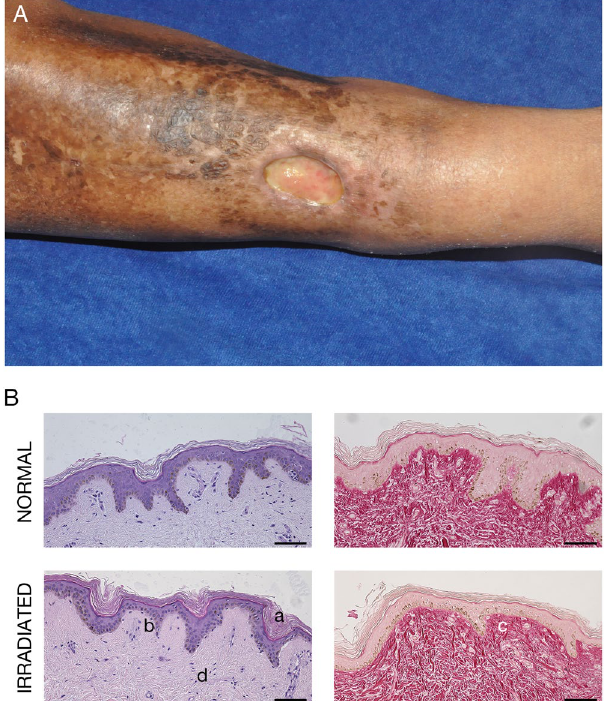
Figure 1. ( A ) Photo of a patient with a non-healing lower extremity wound. Note the skin discoloration associated with radiation injury. ( B ) Representative example of H&E (left) and Sirius red (right) staining of paired normal (top) and irradiated (bottom) human skin samples, demonstrating abnormally thick stratum corneum (a), thin epidermis (b), disordered collagen (c), and chronic inflammatory cells (d) characteristic of radiation-induced skin damage. Scale bars represent 100 µ